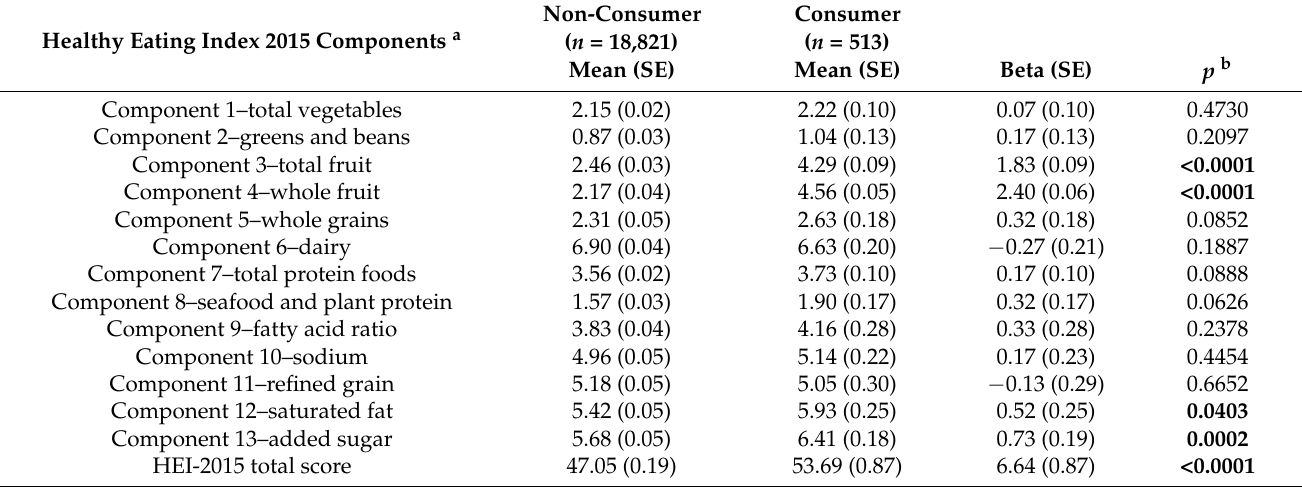
Table 4. Association of watermelon consumption with Healthy Eating Index-2015 total and sub- component scores in children, NHANES 2003–2018, gender combined